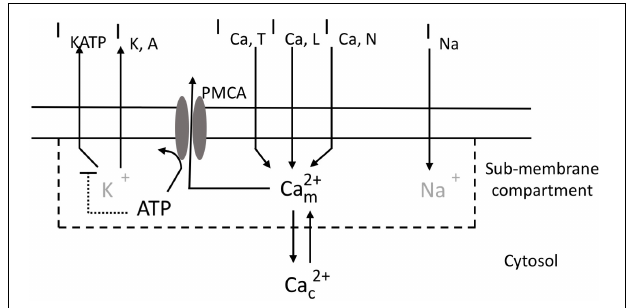
FIGURE 1 | Schematic representation of ionic currents, Ca 2 + fluxes and ATP consumption in pancreatic α -cells. Transmembrane currents are: I KATP , the ATP-sensitive K + current; I KA , the high-voltage activated K + current; I CaL , the high-voltage activated L-type Ca 2 + current; I CaT , the low-voltage activated T-type Ca 2 + current; I CaN , the high-voltage activated N-type Ca 2 + current; I Na , the voltage-gated Na + current. The model describes the evolution of Ca 2 + concentration in a fictitious sub-membrane compartment ( Ca 2 + m ) and in the cytosol ( Ca 2 + c ). Exchanges between these 2 compartments occur by diffusion. Ca 2 + is transported from the sub-membrane compartment into the extracellular medium by the ATP-consuming PMCA. ATP increases in the cytosol at a rate that depends on the concentration of extracellular glucose. ATP inhibits the ATP-sensitive K + current (I KATP ). K + and Na + concentrations (in gray) are not explicitly considered in the